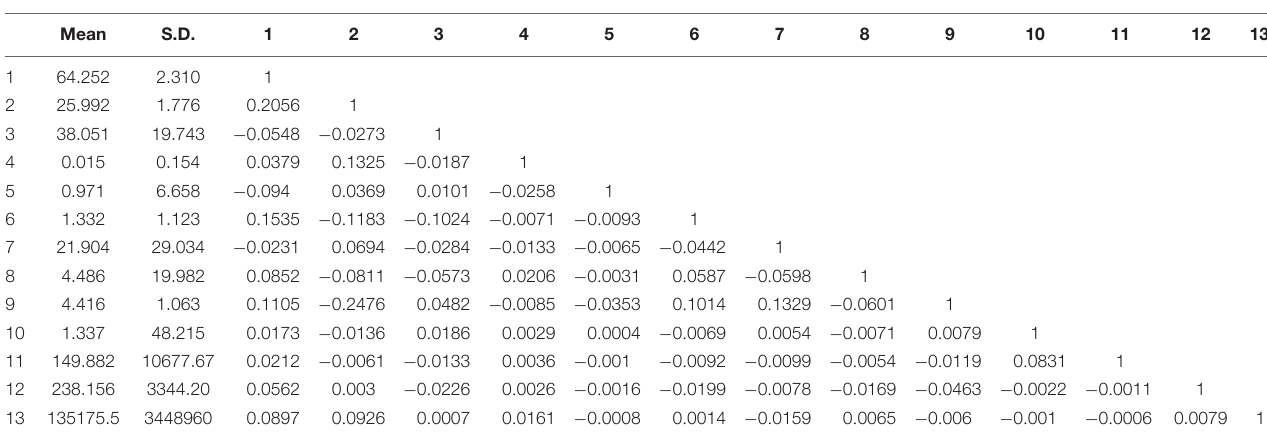
TABLE 1 | Descriptive statistics and